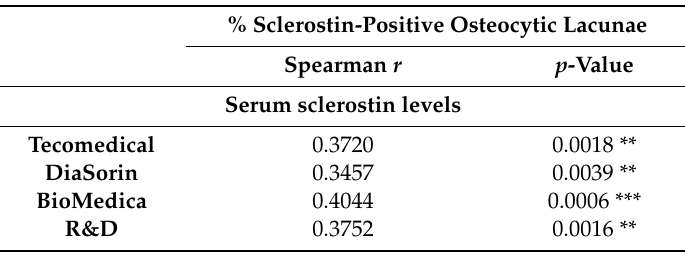
Table 5. Spearman correlation matrix of skeletal sclerostin expression vs. serum sclerostin levels. % Sclerostin-Positive Osteocytic Lacunae Spearman r p -Value Serum sclerostin levels Tecomedical 0.3720 0.0018 ** 0.3457